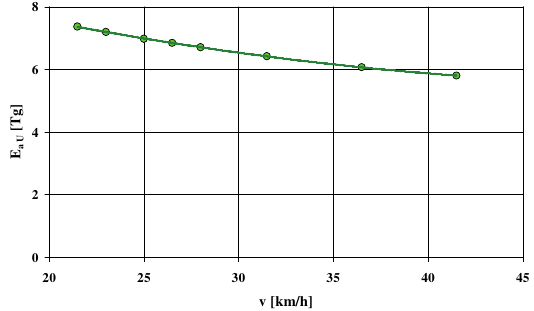
Fig. 15. Dependence of the national annual emission of particulate matter PM2.5 from tribological elements of passenger cars upon the average velocity, under model conditions of traffic on highways and expressways